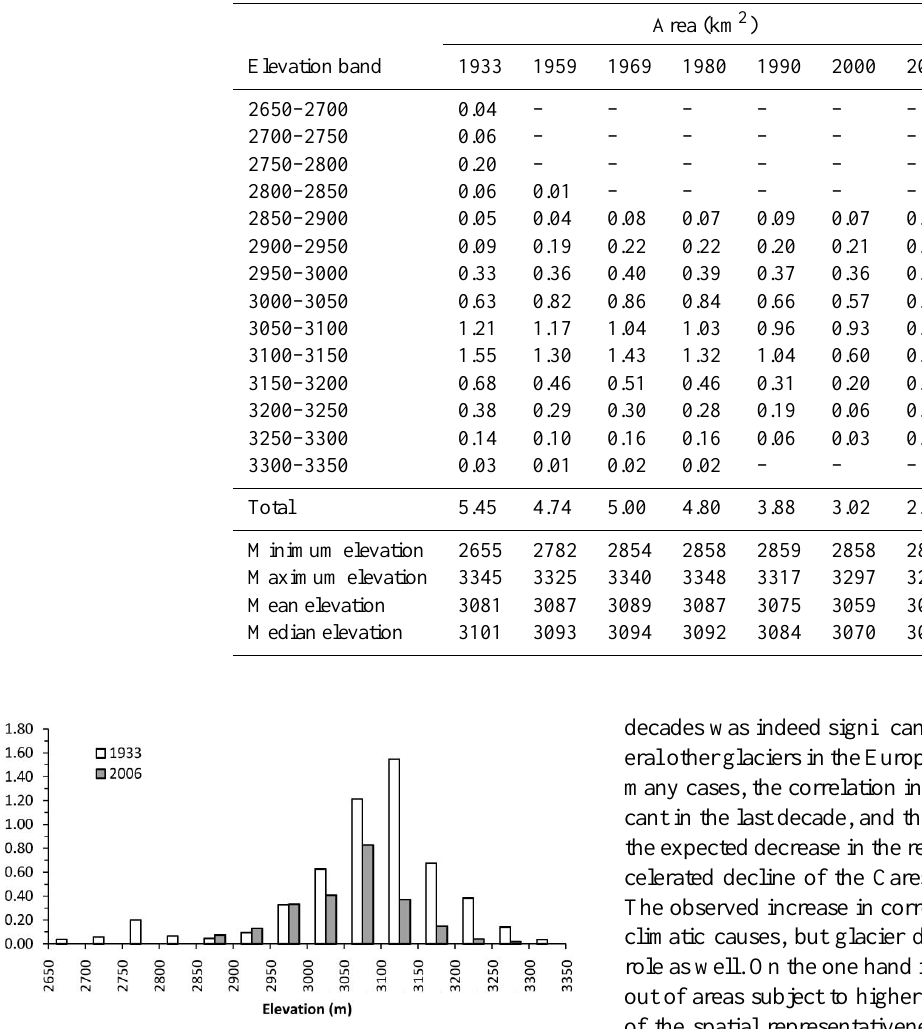
Fig. 12. Hypsography of the Careser Glacier in 1933 and in